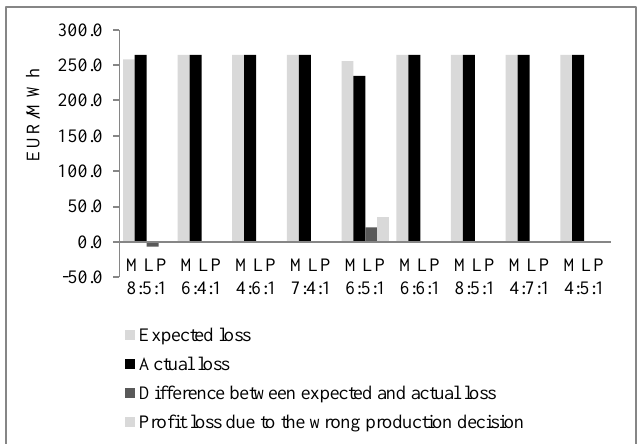
Fig. 9. The impact of electricity price expectations on the profit/loss of the electricity production during 24 hours (calculations made by the